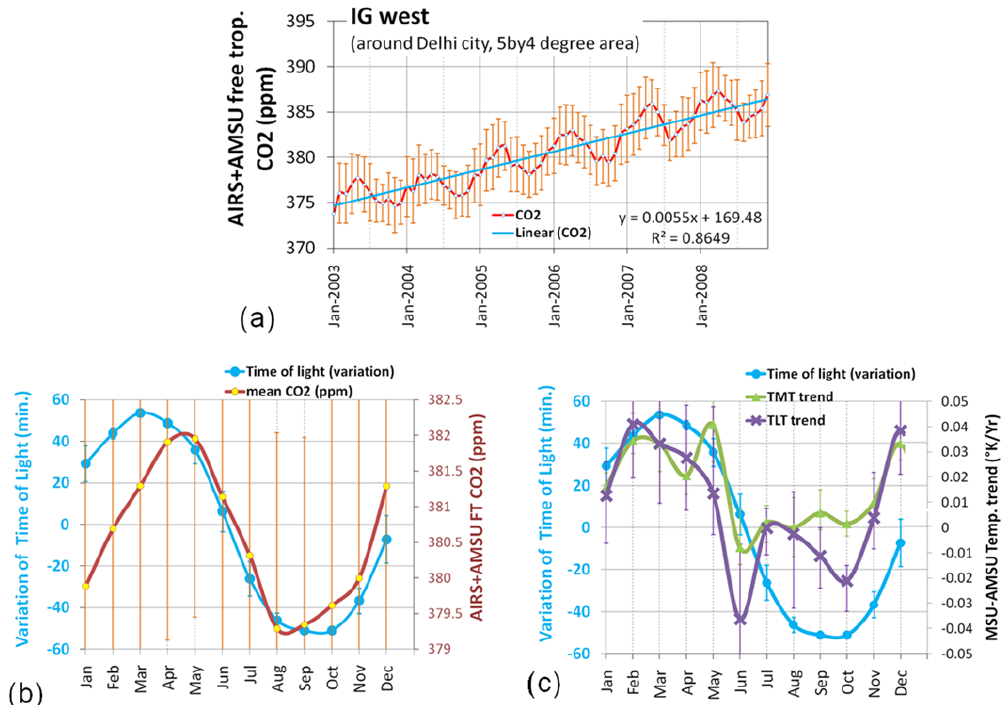
Fig. 5. (a) The increasing trend of free troposphere CO 2 (AIRS+AMSU) over the western IG plains. The seasonal oscillation of CO 2 is prominent. (b) The mean monthly CO 2 show seasonal sinuous pattern of variation which matches well with the observed available sunlight. (c) The six months of warming trend (TMT and TLT) are observed to be during period when the available sunlight duration and CO 2 is on the high (positive) side of the seasonal